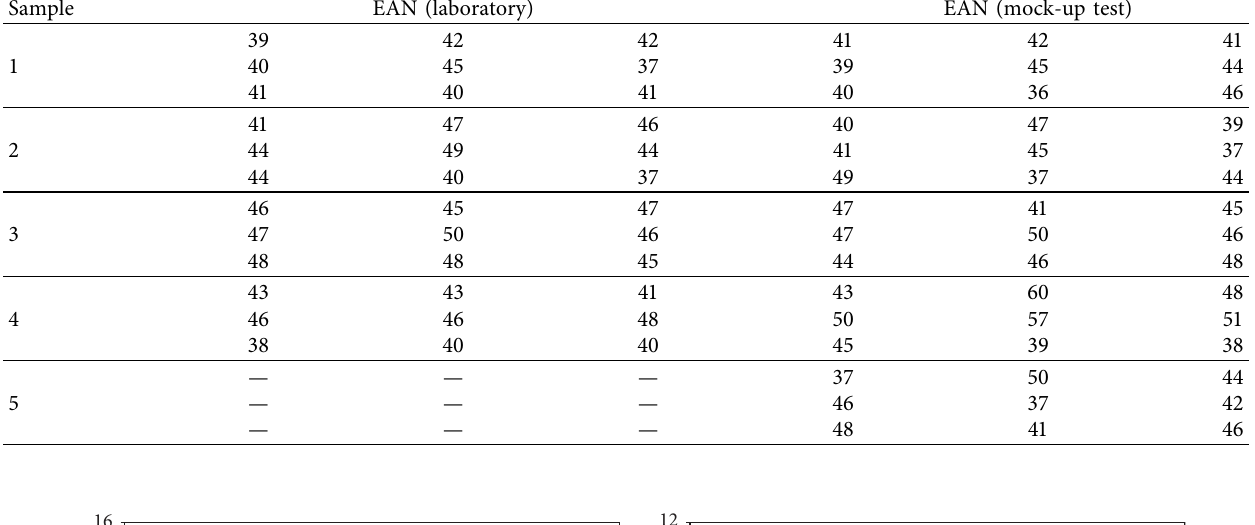
Table 2: Collected exposed aggregate number from laboratory and mock-up